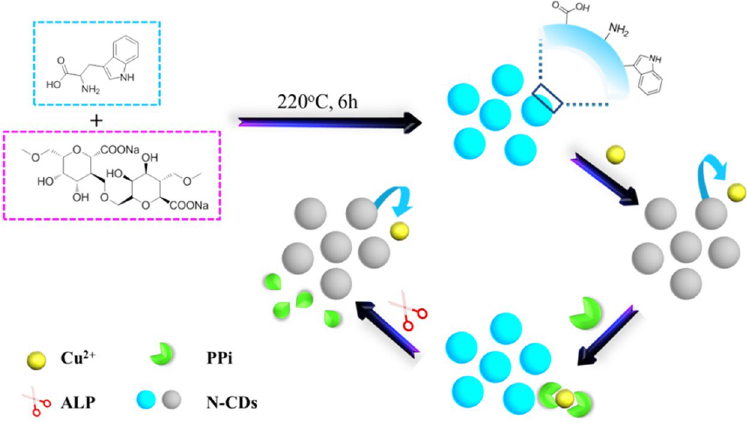
Figure 2. Schematic illustration of the detection strategy for PPi and ALP activity by using